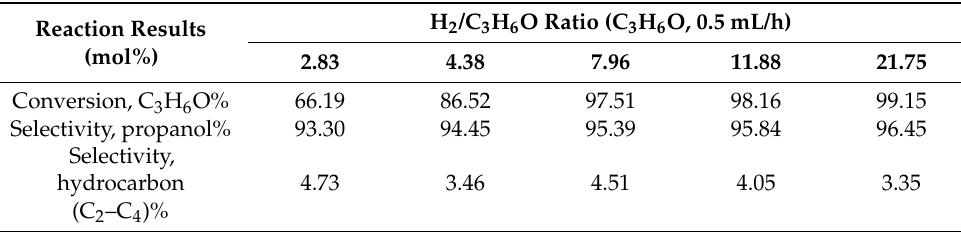
Table 4. The hydrogenation and dehydration results for the propionaldehyde reaction.